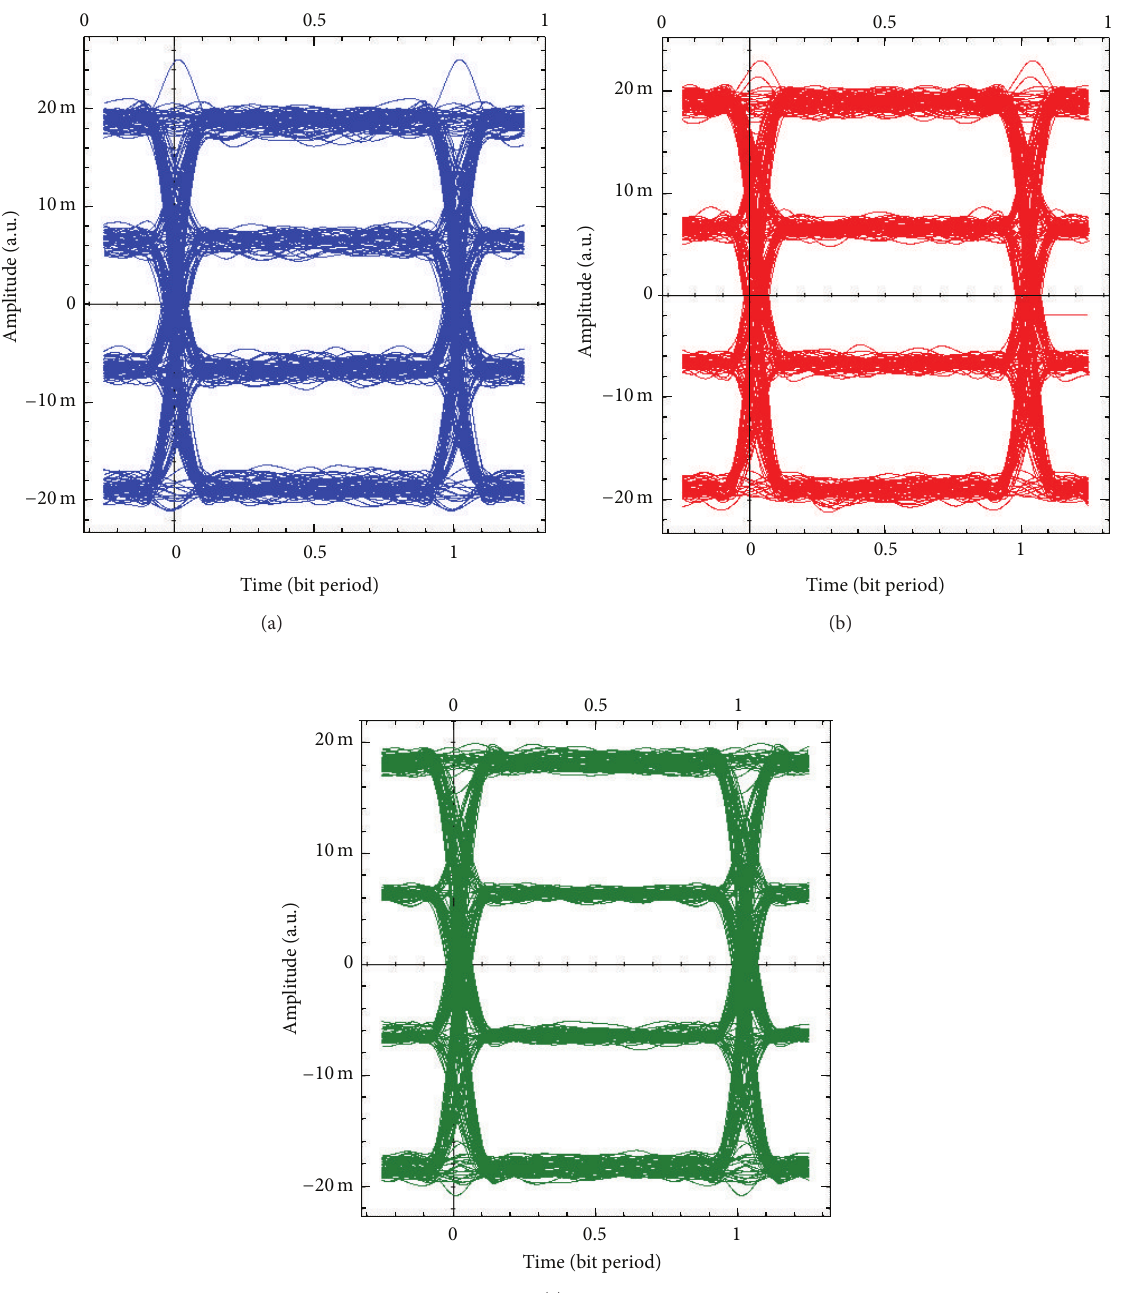
Figure 11: Eye diagrams of the 𝑄 -branch of the demodulated 16 QAM baseband signals for (a) MIMO 1 , (b) MIMO 2 , and (c) MIMO 3 .